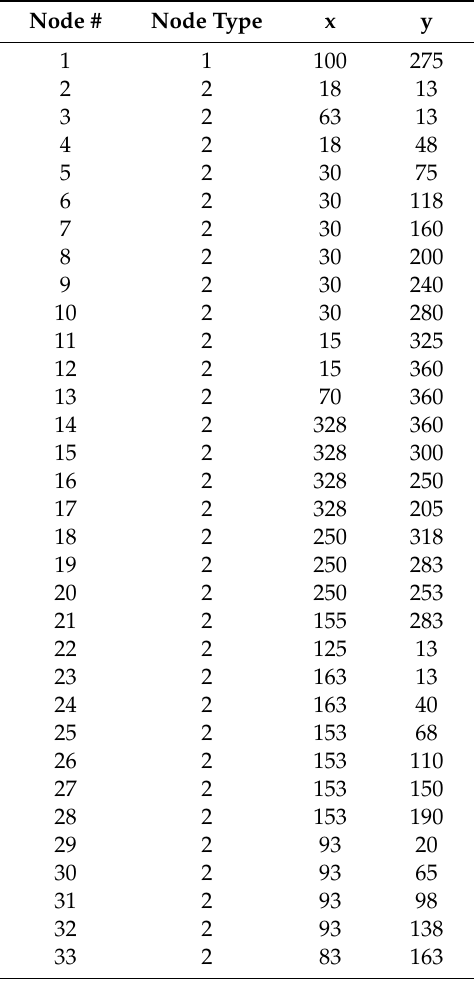
Figure5. Casestudy3: ( a )Initiallayout; ( b )synthesizednetworkusingtheCADtool; and( c )synthesized network using the proposed approach. Table 3. Nodes of the synthesized network using the proposed approach for case study